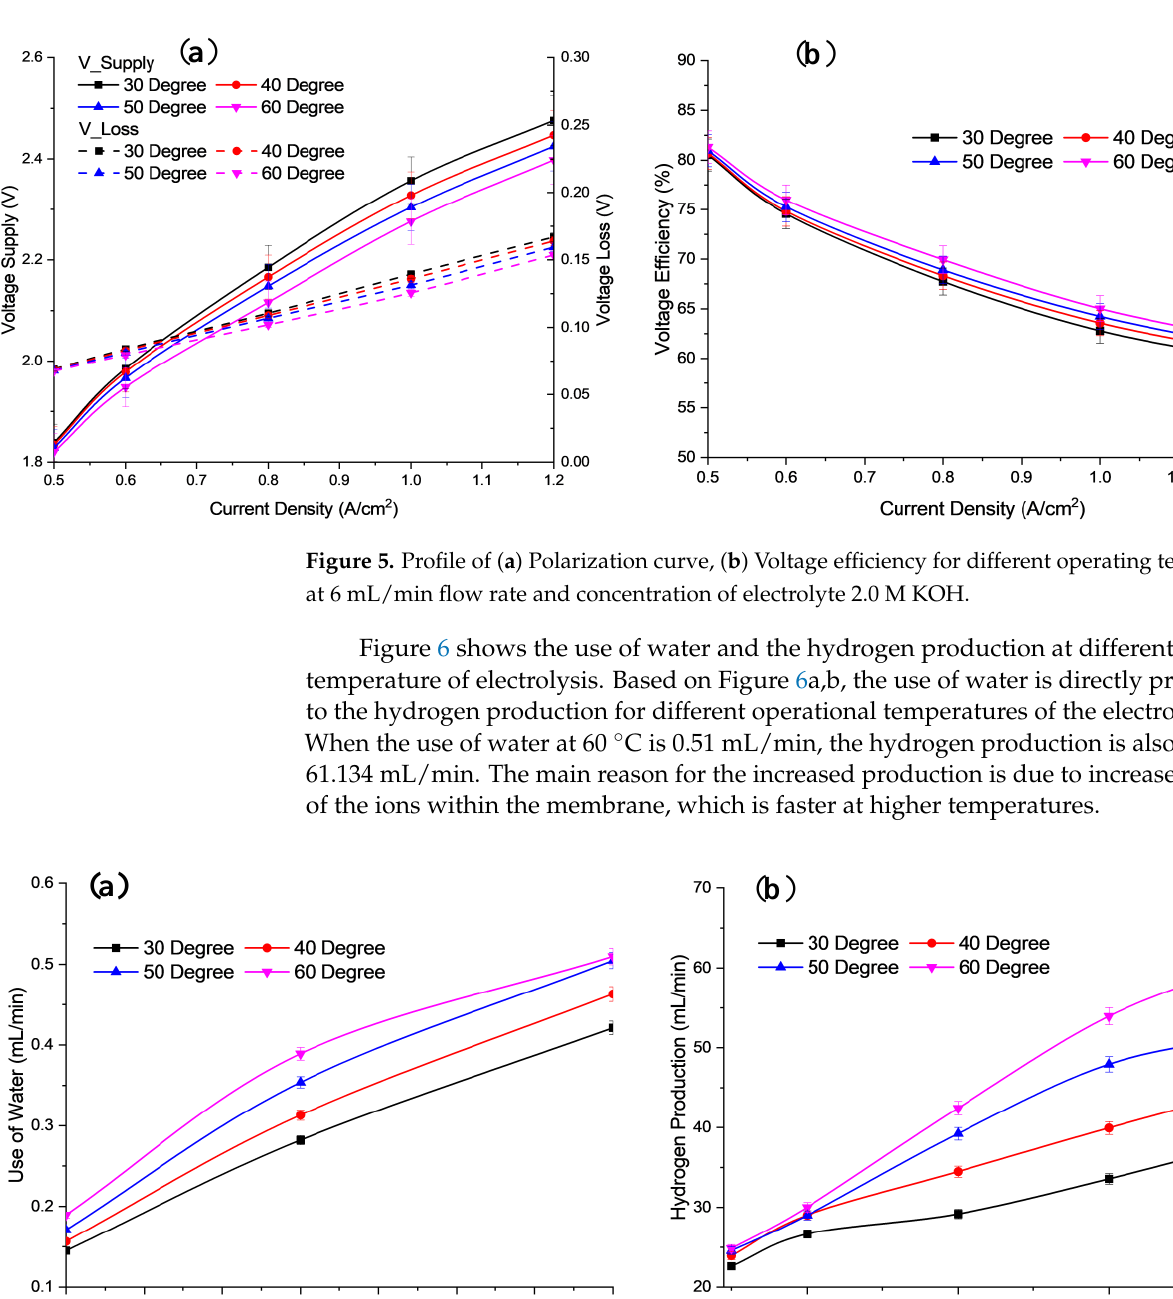
8 of 16 Figure 4. Profile of energy consumption and energy efficiency of electrolysis performance for dif- ferent alkaline concentrations at 6 mL/min flow rate and 30 °C in operating temperature. 3.2. Effect of Operating Temperature Figure 5a shows a comparison of polarization curves at 30 – 60 °C obtained in this work. Figure 5b shows a comparison of voltage efficiency at 30 – 60 °C. Initially, cell volt- age shows an increase as the temperature decreases. Then, for 30 °C and 40 °C, the cell voltage increases slowly when the current density exceeds 0.6 A/cm 2 . At 60 °C, the volt- age efficiency is higher than the cell voltage efficiency at 50, 40, and 30 °C. A high tem-